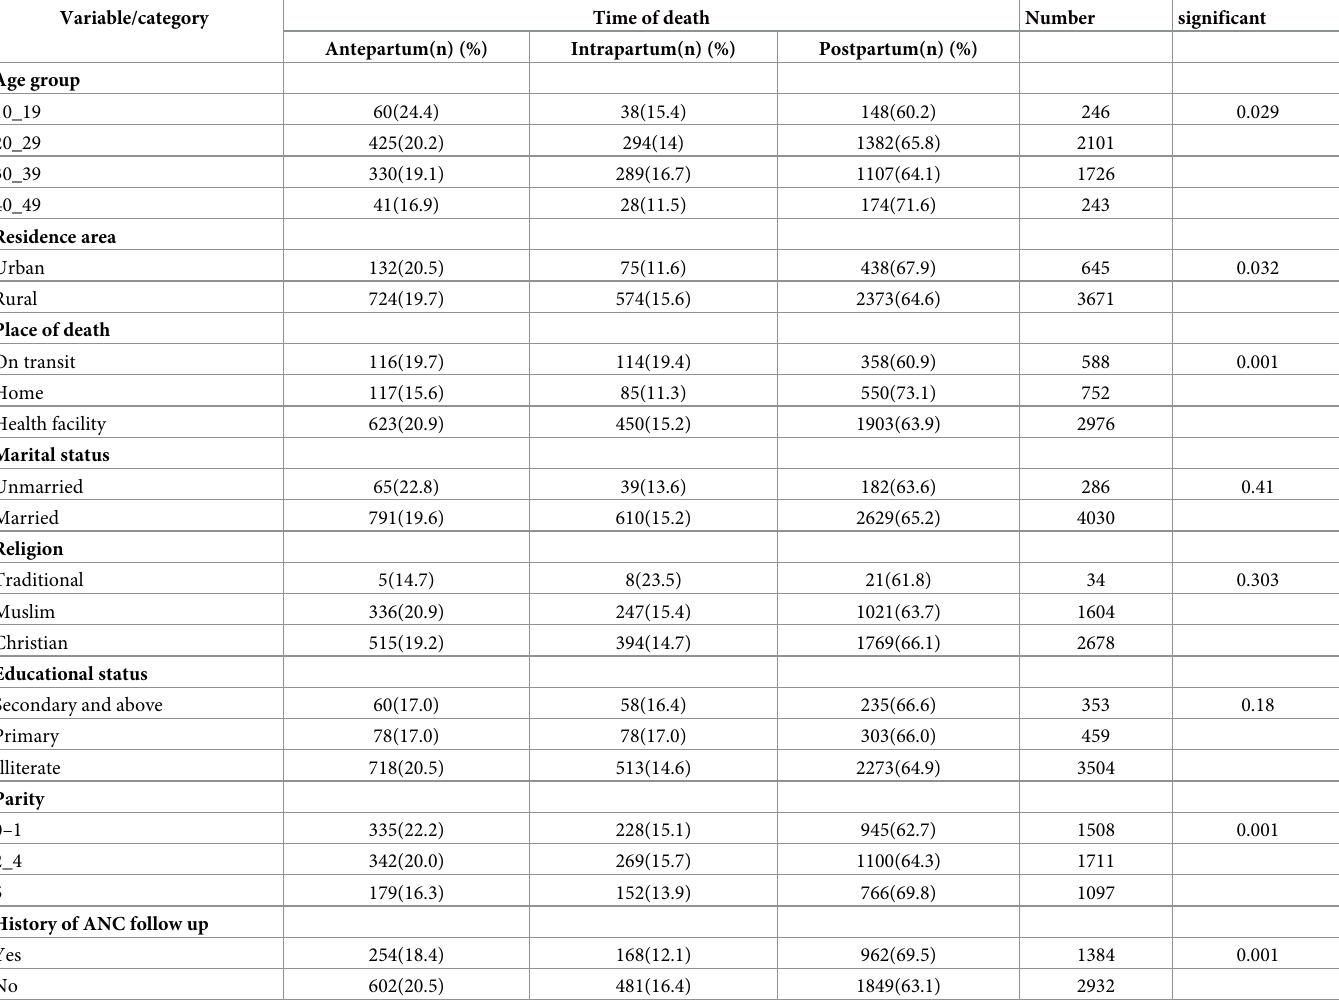
Table 2. Distribution of personal characteristics by time of death among reviewed maternal death in Ethiopia, 2020.